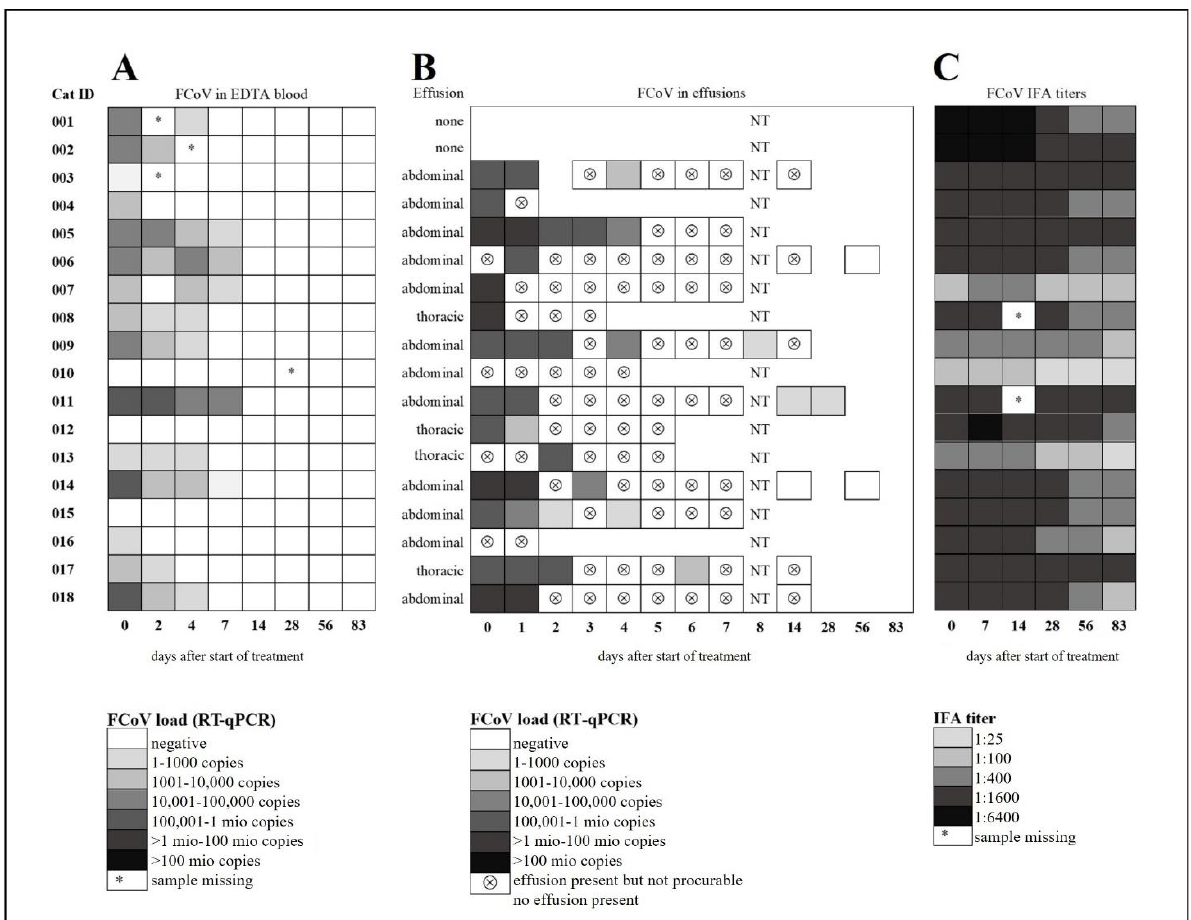
Figure 5. Feline coronavirus (FCoV) viral RNA loads in blood and effusion samples and serum anti-FCoV antibody titre measurements. ( A ) FCoV RNA loads in EDTA anticoagulated blood. ( B ) FCoV RNA loads in effusions. ( C ) Serum anti-FCoV antibody titres. FCoV RNA loads were determined by quantitative reverse transcriptase polymerase chain reaction (RT-qPCR) ( A , B ). Antibody titers were determined by indirect immunofluorescence assay (IFA). NT, not tested.